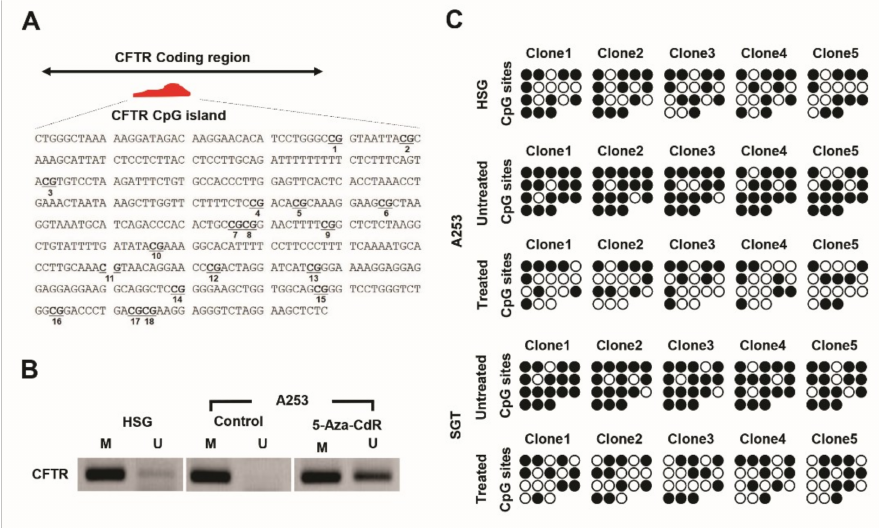
Figure 3. CpG island hypermethylation and hypomethylation of CFTR in A253 cells before and after treatment with 5-Aza-CdR. ( A ) The CFTR CpG islands (GenBank #NM 031506) were analyzed. This coding region consists of 18 CG pairs as potential CpG sites within this sequence. These 18 CG sites are bolded and underlined. ( B ) Methylation levels of HSG and A253 with or without 5-Aza-CdR were assessed using methylation-specific PCR (MSP) in a sodium bisulfate-modified DNA sample. Methylation, M; unmethylation, U. Lack of unmethylated band in A253 cells. Strong unmethylated band in 5-Aza-CdR-treated A253 cells showing hypomethylation of CFTR. ( C ) Bisulfite genomic sequencing showing CpG island methylation of CFTR. (Unmethylated cytosine, open circle; methylated cytosine, closed circle.) Hypermethylation patterns in A253 cells compared with HSG cells. Hypomethylation of CFTR CpG islands in A253 cells in the presence of 5-Aza-CdR. All experiments were performed in